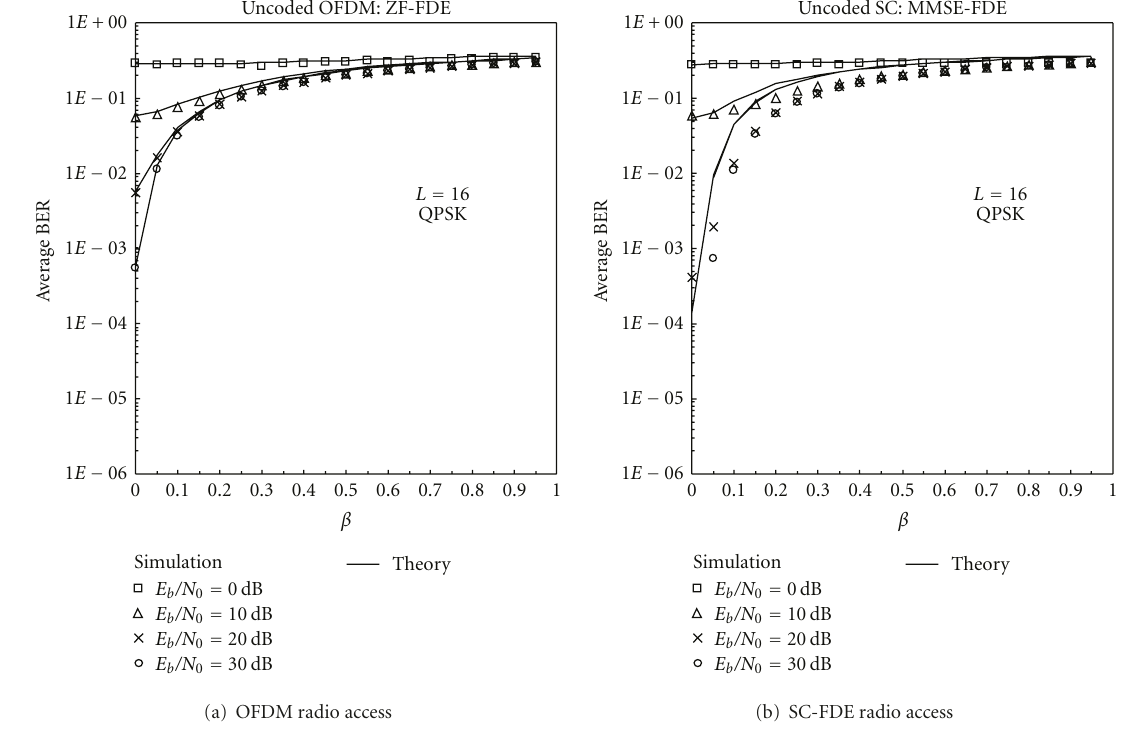
Figure 2: Uncoded BER versus β of broadband